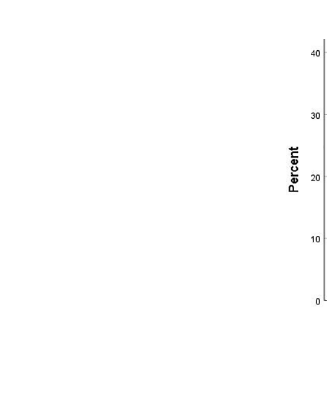
FIGURE 1 | Distribution of the patients by age at